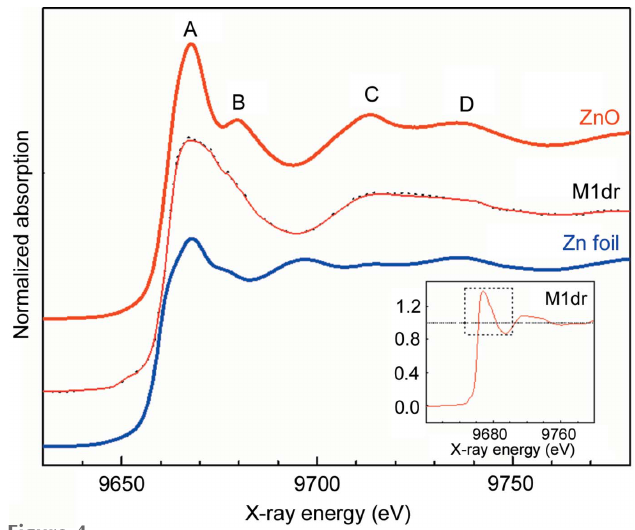
Figure 4 Normalized Zn K -edge XANES spectra for Zn foil and ZnO powder standards and for M1dr solution. Datasets are shifted relative to each other for clarity. Raw (black dotted) and smoothened (pink solid) datasets for M1dr are overplotted. Inset: magnified image of the white line for M1dr. White-line intensity = 1.35 suggests N = 4 coordination of